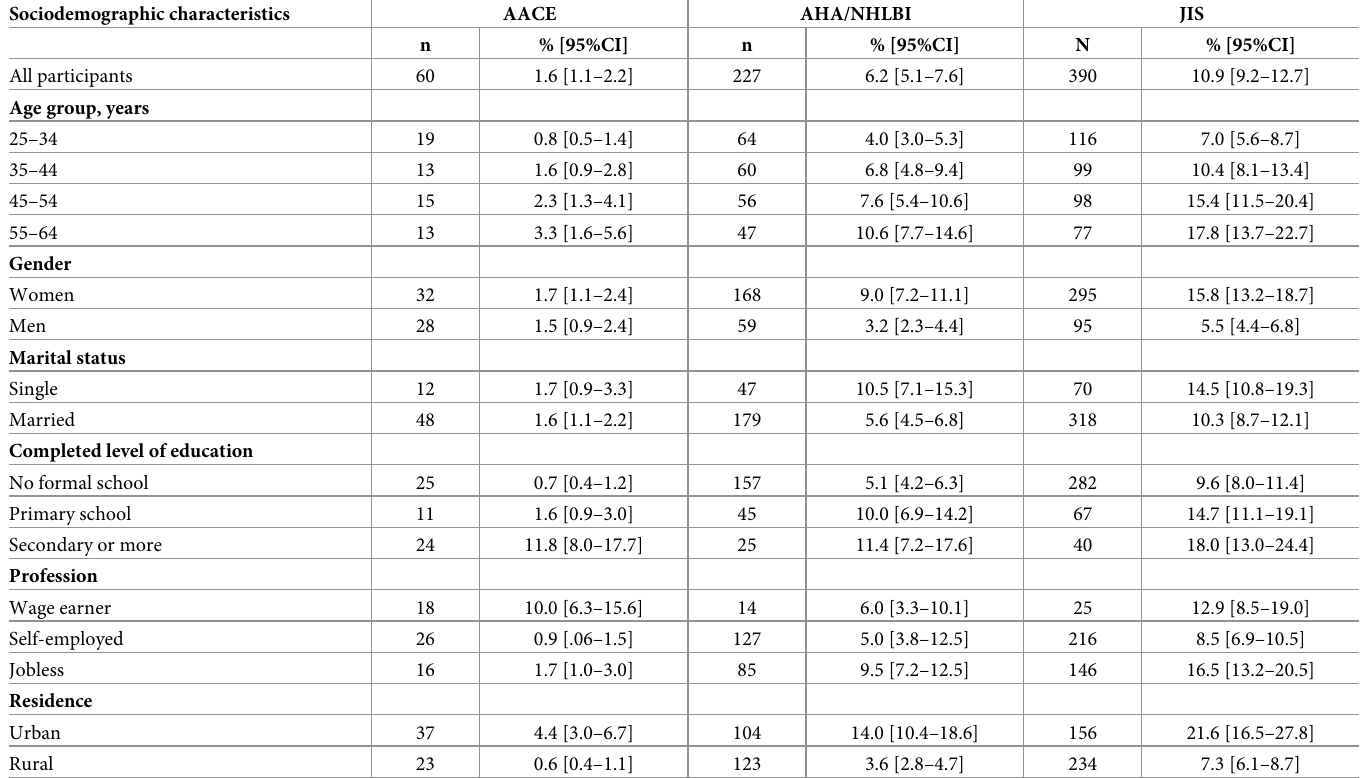
Table 5. Prevalence of metabolic syndrome according to each of six definitions by sociodemographic characteristics. Sociodemographic